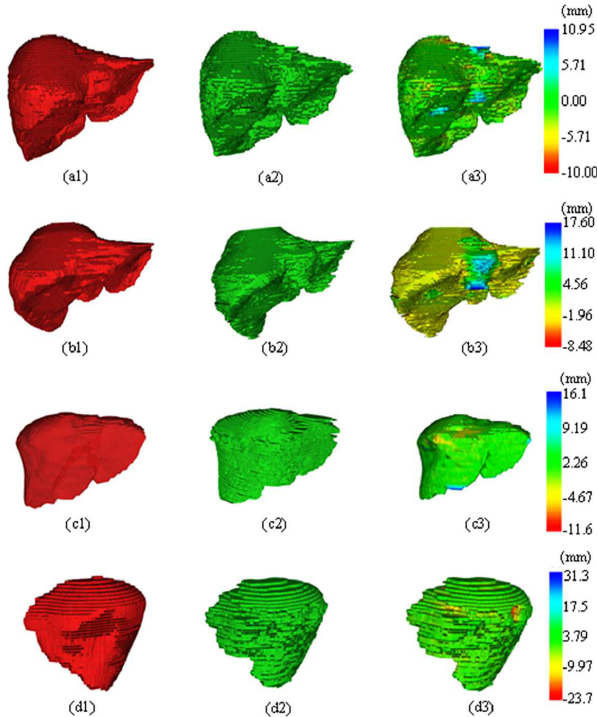
Fig 10. Results of 3D rendering, fusion and distance error map for four test